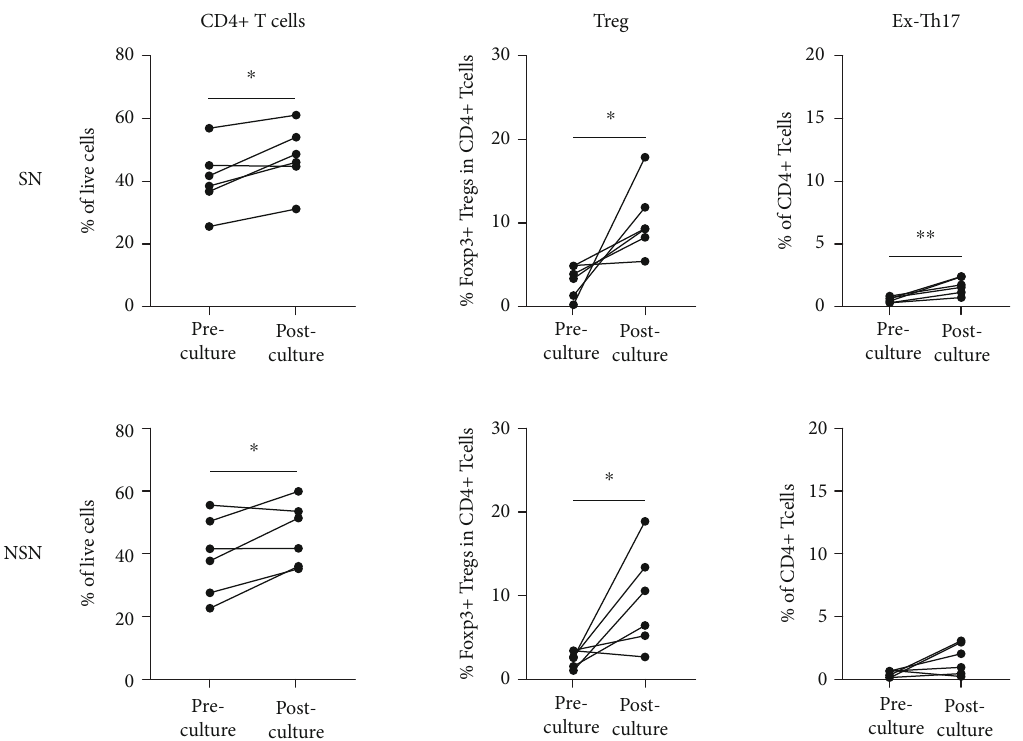
Figure 6: Changes in immunophenotype of lymph nodes after ex vivo culture. ∗ p < 0 : 05 and ∗∗ p < 0 : 01 .